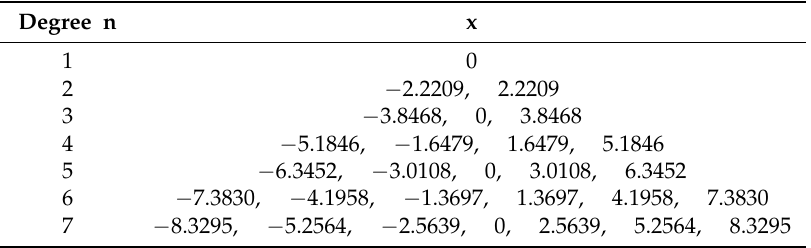
Table 2. Approximate solutions of H n ( x , y , λ ) = 0, x ∈ R